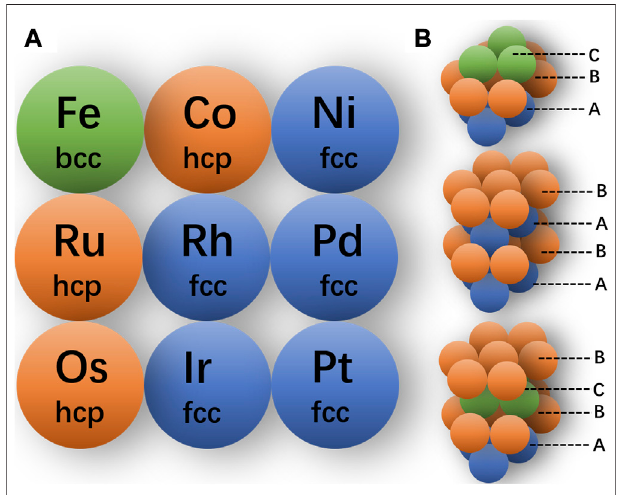
FIGURE7|(A) Conventionalcrystalphasesofsometransitionmetal. (B) Atomic packing models of crystal phase fcc, hcp-2H, and hcp-4H from top to bottom.